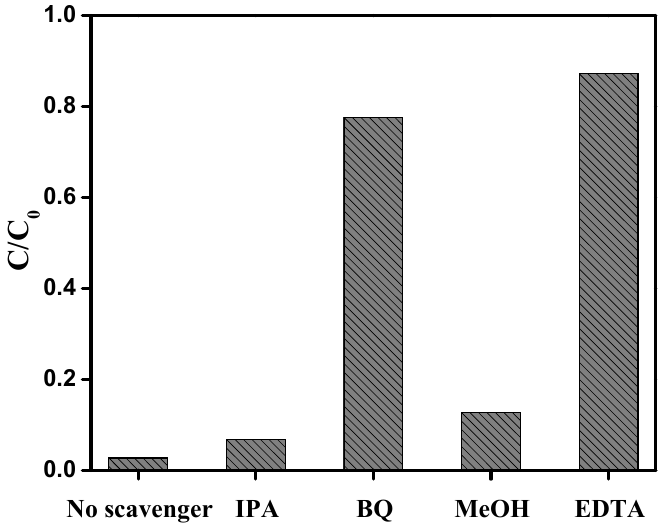
Figure 10. The radical trapping experiment in the PMS activation by BC-3 nanocomposite for BPA degradation. Reaction condition: initial BPA concentration of 10 mg/L, PMS dosage of 1 mmol/L, catalyst addition of 1 g/L.